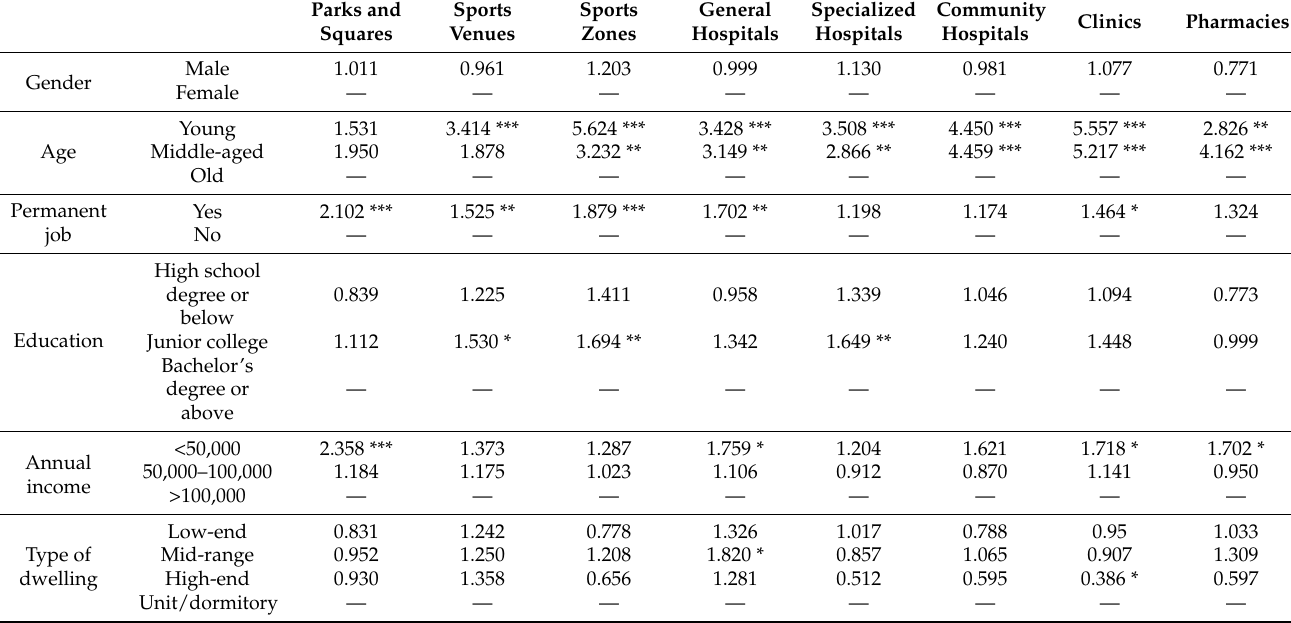
Table 6. Ordinal logistic model parameters for satisfaction with service.